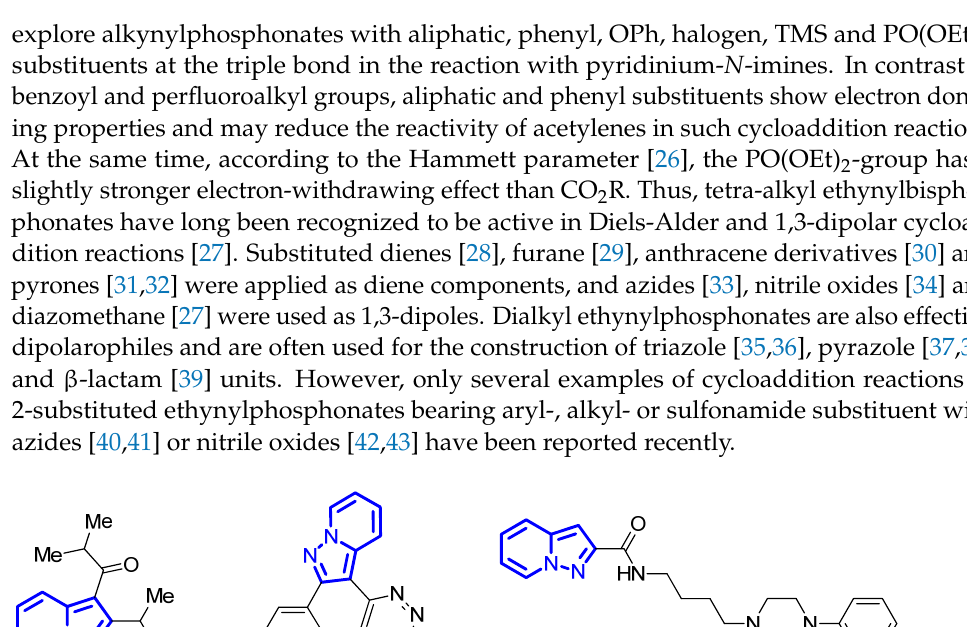
Figure 1. Biologically active derivatives of pyrazolo[1,5- a